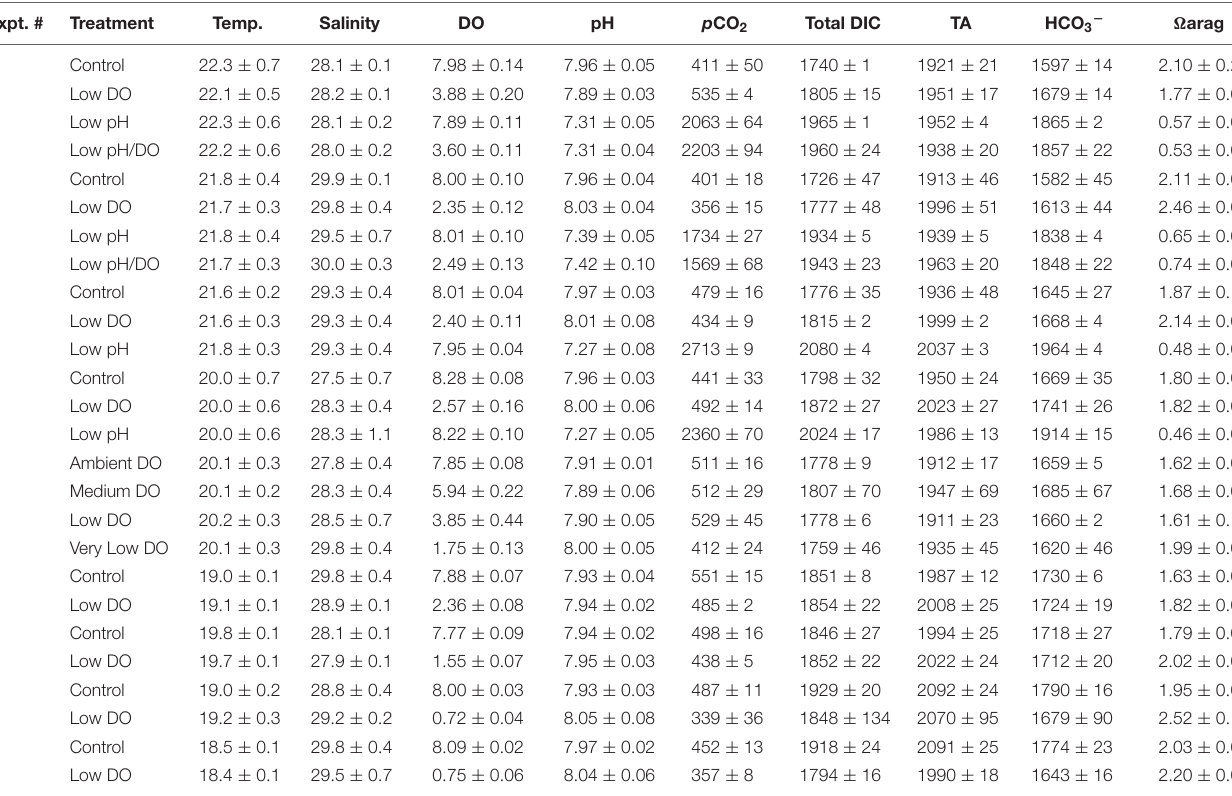
TABLE 1 | Values of temperature ( ◦ C), salinity (g kg − 1 ), dissolved oxygen (DO; mg L − 1 ), pH (total scale), p CO 2 ( µ atm), total DIC ( µ mol kgSW − 1 ), total alkalinity (TA; µ mol kgSW − 1 ), HCO 3 − ( µ mol kgSW − 1 ), and the saturation state of aragonite ( (cid:127) arag ) for Experiments 1 – 9. Expt. #